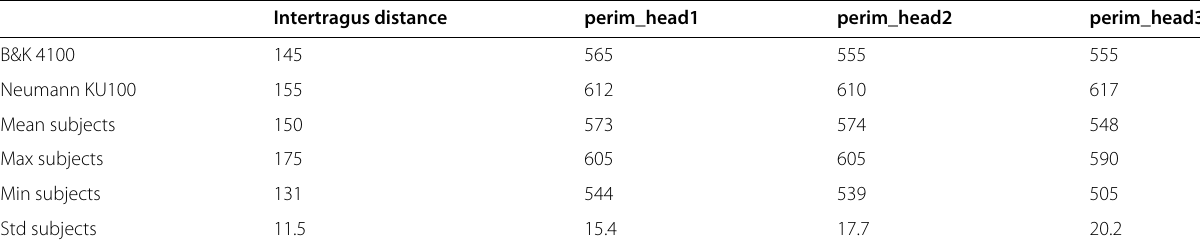
Table 1 Summary of anthropometric measurement data